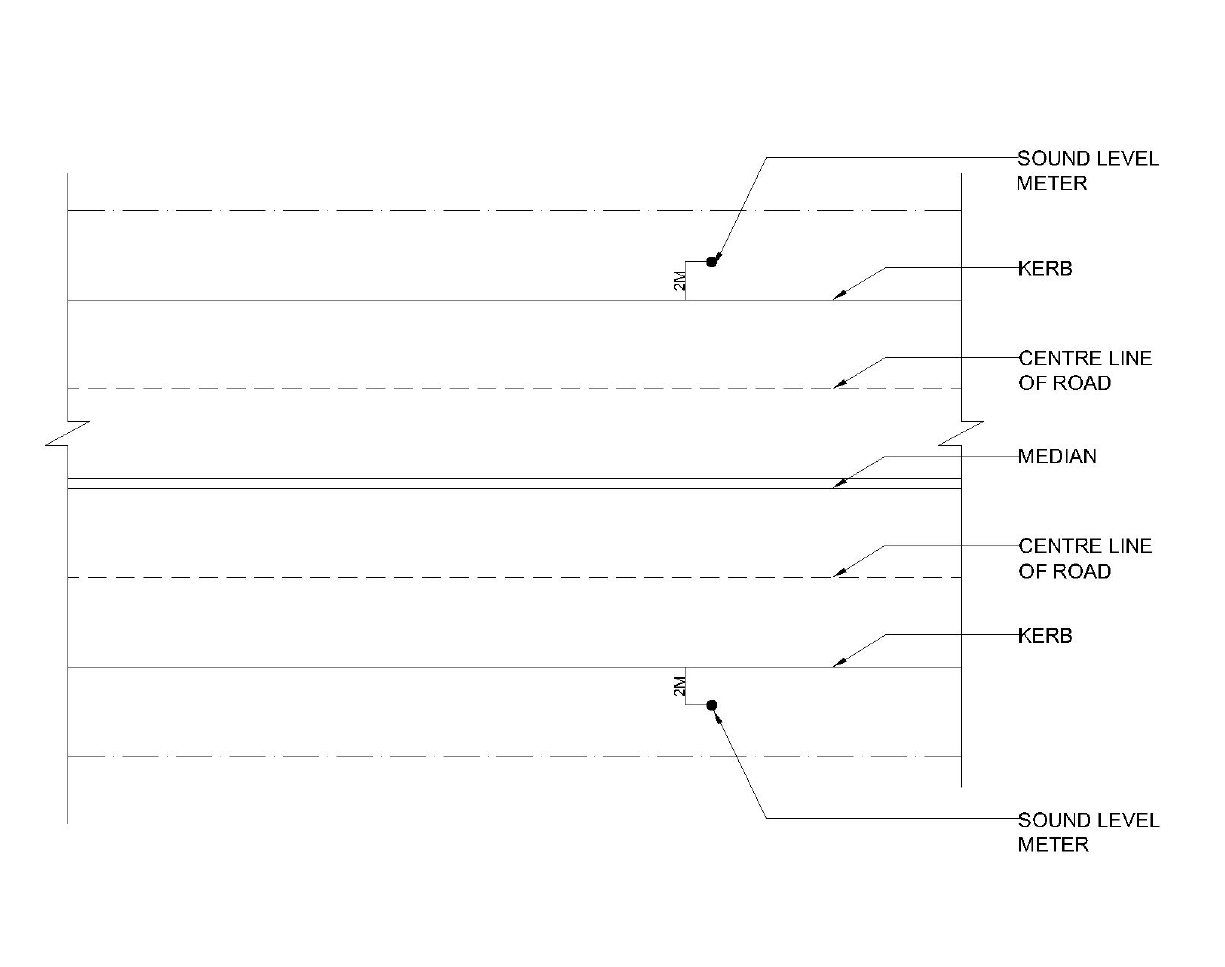
Figure 3: Position of sound level meter on both side of the road